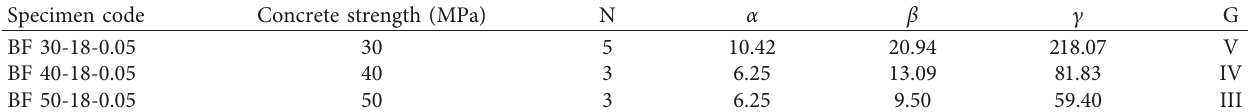
Table 12: Crack resistance indices of test specimens with different concrete strength values.